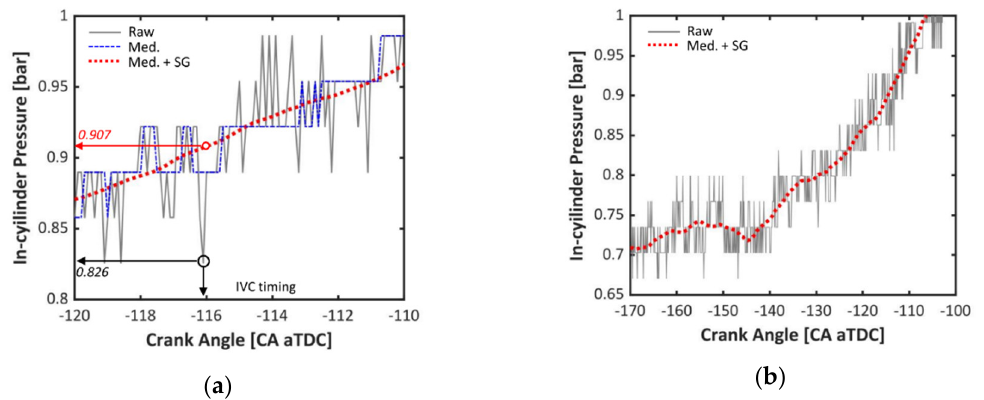
Figure 7. Filtering of in-cylinder pressure in low-pressure region: ( a ) Median and Savitzky-Golay filtering; ( b ) Overall shape of the pressure signal with newly applied filter.